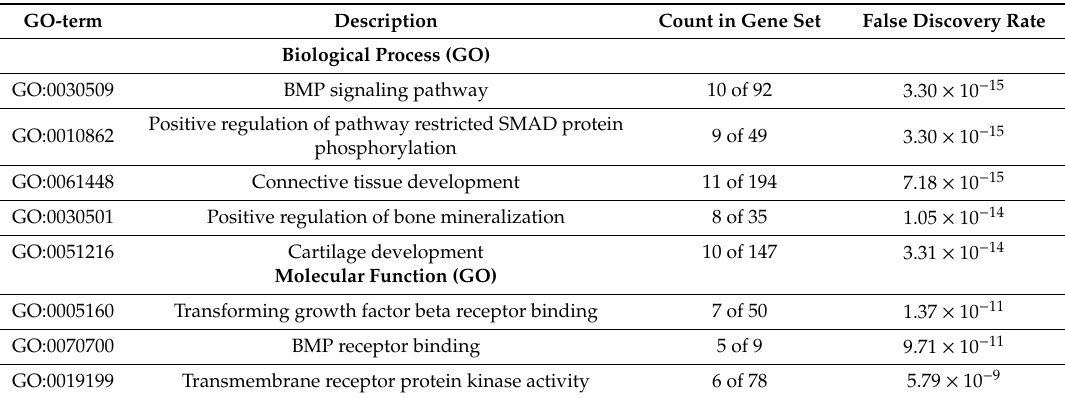
Table 3. STRING: Biological Processes (GO), Molecular Function (GO), Cellular Components with KEGG, and Reactome Pathway for the NIPA1